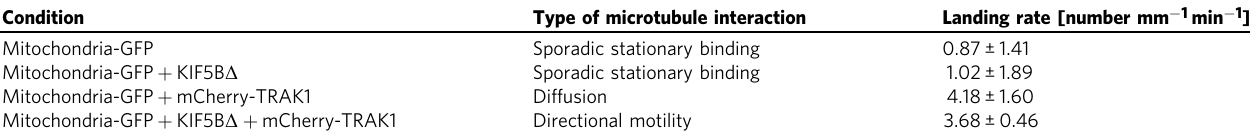
Fig. 5 TRAK1 enables mitochondrial transport in vitro. a Schematic illustration and kymographs of mitochondria-GFP (cyan) being processively transported along microtubules by mCherry-TRAK1 (magenta), bound to unlabelled KIF5B Δ . Horizontal scale bars 5 µ m, vertical 10 s. See also Supplementary Fig. 5. b Histograms of the average velocities of the processive movement of KIF5B Δ -GFP (green, same dataset as in Fig. 2f), decreased in presence of mCherry-TRAK1 (magenta, same dataset as in Fig. 2f) and further decreased for mitochondria-GFP transported by KIF5B Δ -mCherry-TRAK1 complexes (cyan, n = 72 mitochondria, N = 10 experiments). c Survival probability plot showing an increased median run length of mitochondria-GFP transported by KIF5B Δ -mCherry-TRAK1 complexes (cyan, n = 72 mitochondria, N = 10 experiments) in comparison to KIF5B Δ -GFP (green, same dataset as in Fig. 2d) ( p < 10 − 4 ) and KIF5B Δ -GFP-mCherry-TRAK1 complexes (magenta, same dataset as in Fig. 2d) ( p < 10 − 4 ). Two-tailed p -values were obtained by a log-rank test. d Histograms of the background subtracted fl uorescence intensity of KIF5B Δ -mCherry (green, 1.0 ± 0.5 (median ± interquartile range (IQR), n = 105 molecules, N = 2 experiments)) and of mCherry-TRAK1 in presence of KIF5B Δ and mitochondria-GFP (cyan, 6.7 ± 5.77 (median ± IQR, n = 73 mitochondria, N = 10 experiments)) showing on average three to four mCherry-TRAK1 dimers bound to a single mitochondrion (Methods). For labelling Spectrometry of mitochondria). Source data are provided as a Source data fi le. Table 1 Binding behaviour of mitochondria to microtubules and the respective landing